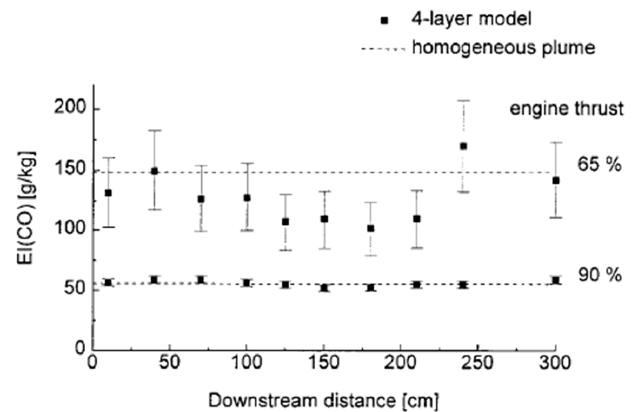
Figure 4. CO emissions at two different thrust levels for the engine ~65% and 90% taken at different locations downstream of the M701TZ engine. Reprinted with permission from Ref. [27] (1997).